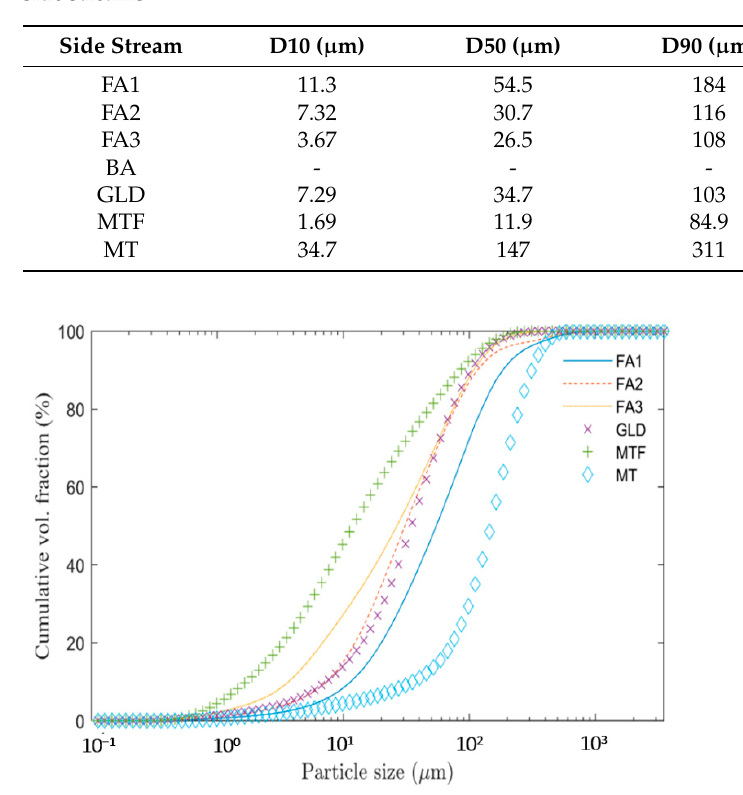
Figure 1. Cumulative particle size distributions of the samples.